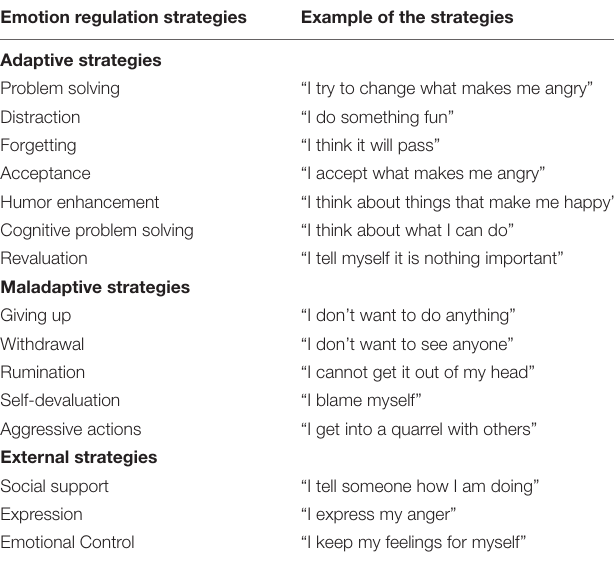
TABLE 1 | Emotion regulation strategies of the FEEL-KJ. Emotion regulation strategies Example of the